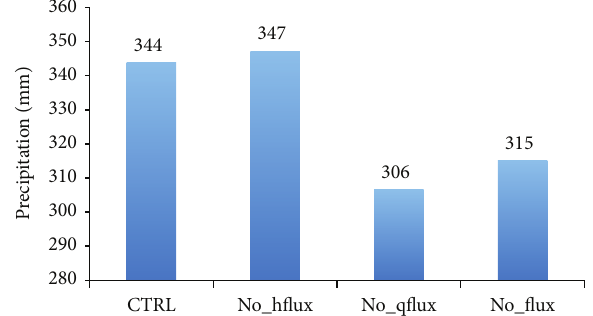
Figure 10: Area averaged 54 h accumulated rainfall (units: mm) calculated over Taiwan